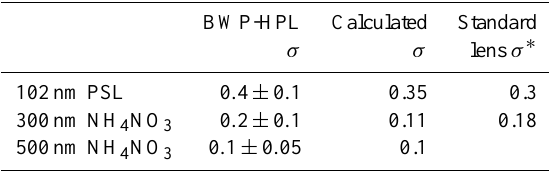
Table 4. Measured and calculated particle beam widths.